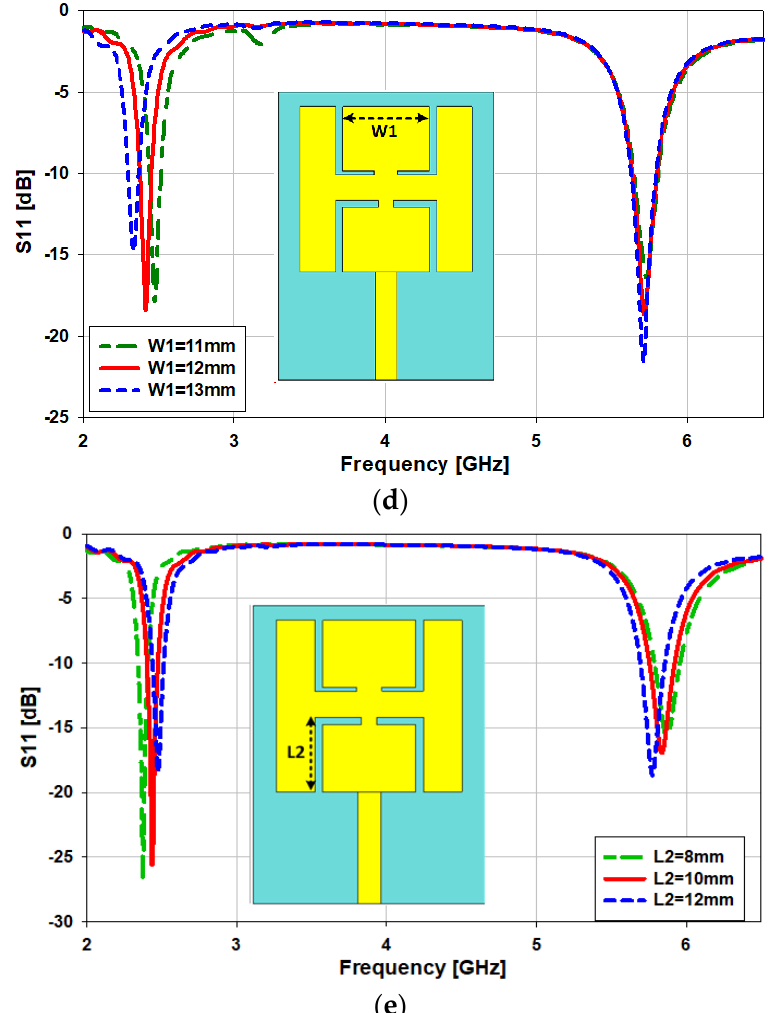
Figure 5. Optimization of the critical parameters of the antenna, ( a ) variation in the upper horizontal slot “ Uhs ”, ( b ) variation in the lower horizontal slot “ Lhs ”, ( c ) variation in the length of the patch “ L1 ”, ( d ) variation in the width of the patch “ W1 ”, ( e ) variation in the length of the slot “ L2 ”.